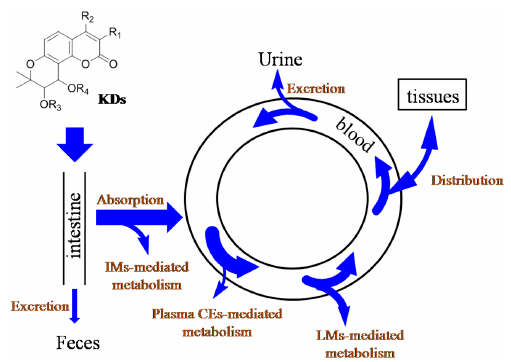
Figure 7. Schematic illustration of the absorption, metabolism, distribution and excretion (ADME) courses of khellactone derivatives following oral administration. IM: intestinal microsomes; LM: liver microsomes; plasma CEs: carboxylesterases.